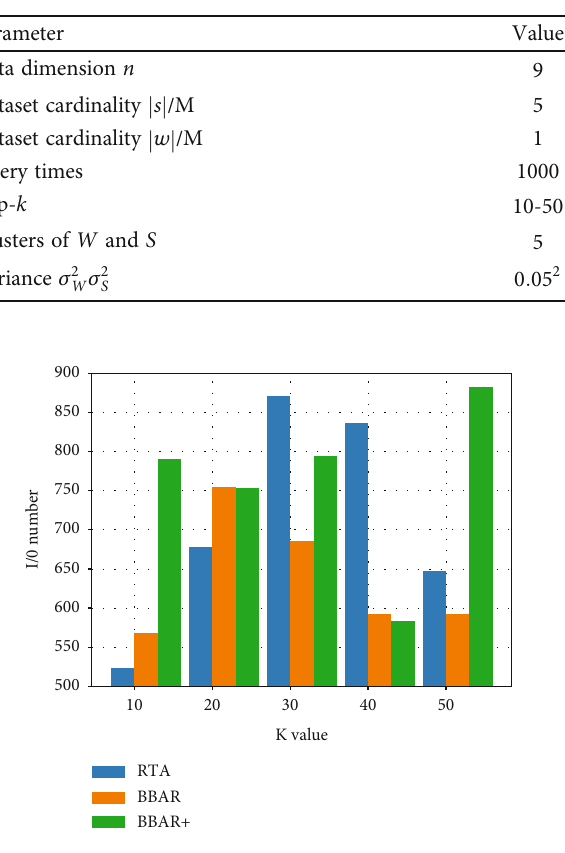
Figure 1: Comparison of the time performance of various algorithms.